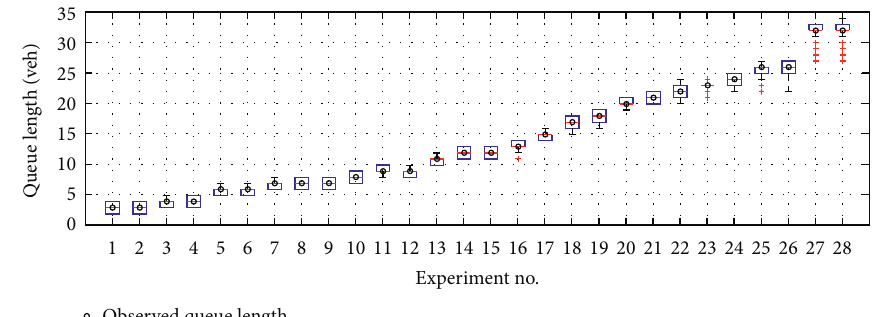
Figure 9: Comparison of queue lengths at every second in the evolution between simulations and observation in one case.